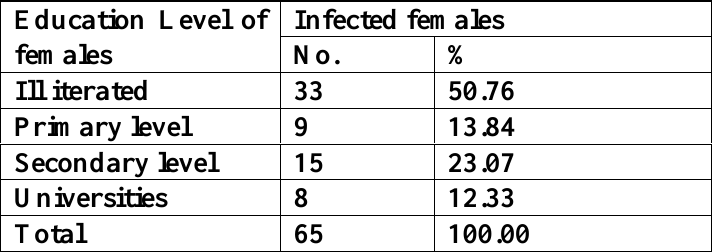
Table (5) : relation between T. Vaginalis infection and education level